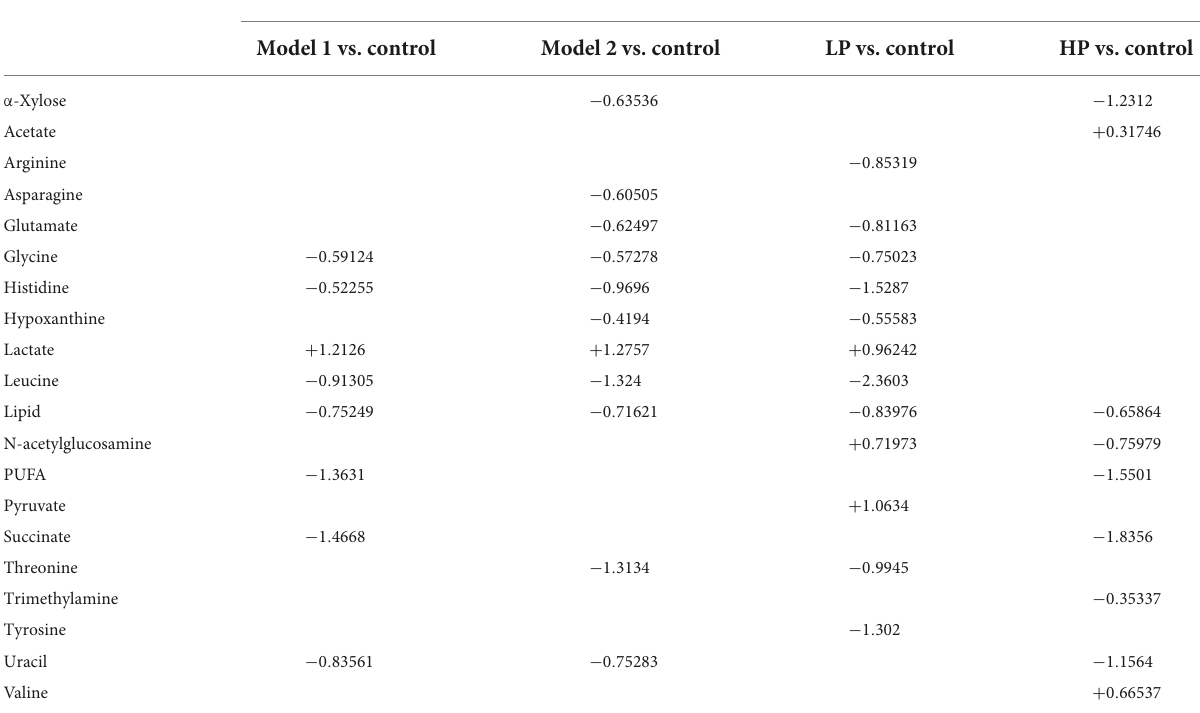
TABLE 1 Correlation coefficients of fecal differential metabolites between different paired comparison groups. Metabolites FC Model 1 vs. control